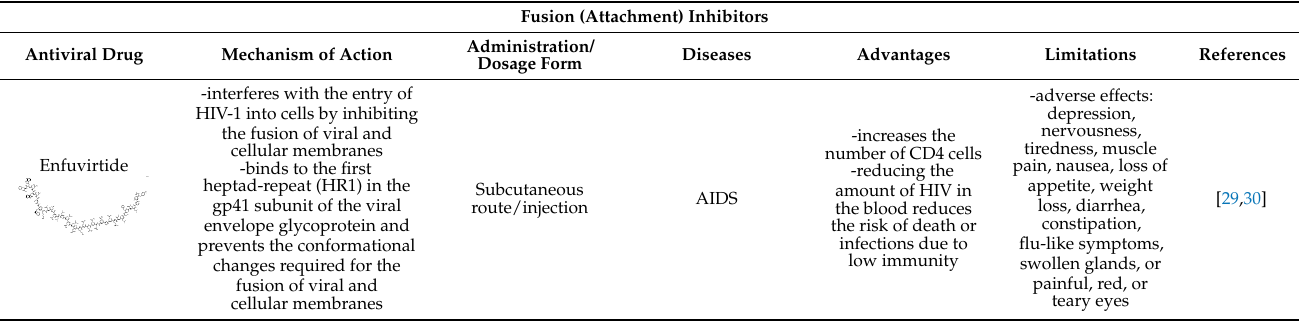
Table 1. Current antivirals divided according to their mechanism of action, drug administration approaches, and dosage forms. Fusion (Attachment) Inhibitors Administra- Antiviral Drug Mechanism of Action tion/Dosage Diseases Advantages Limitations References Form